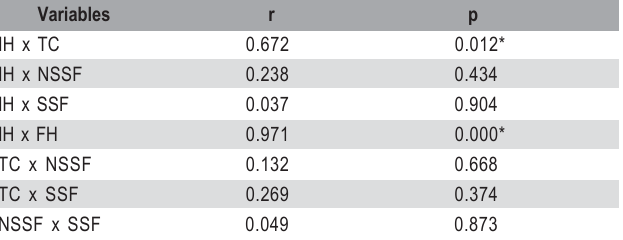
Table 2 - Pearson’s correlation test between the variables and halitosis in Group I.